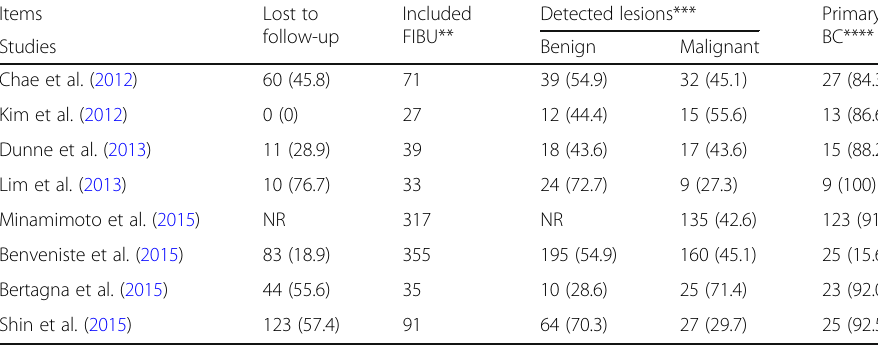
Table 2 Results of further investigation on included patients with detected focal incidental breast uptake* Items Lost to follow-up